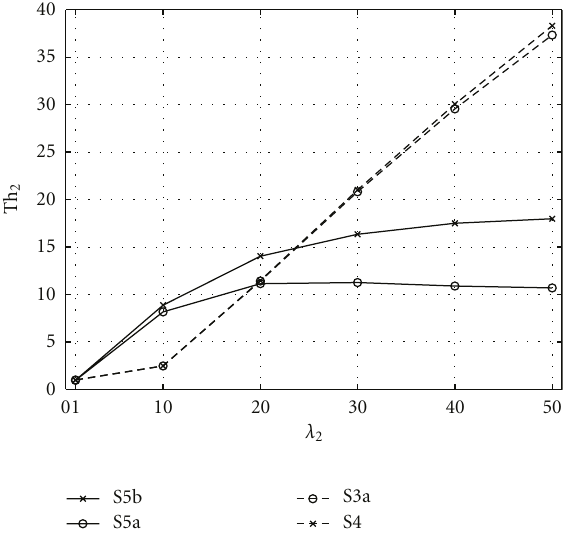
Figure 7: SUs throughput with λ 2 in S5a, S5b, S3a and S4.